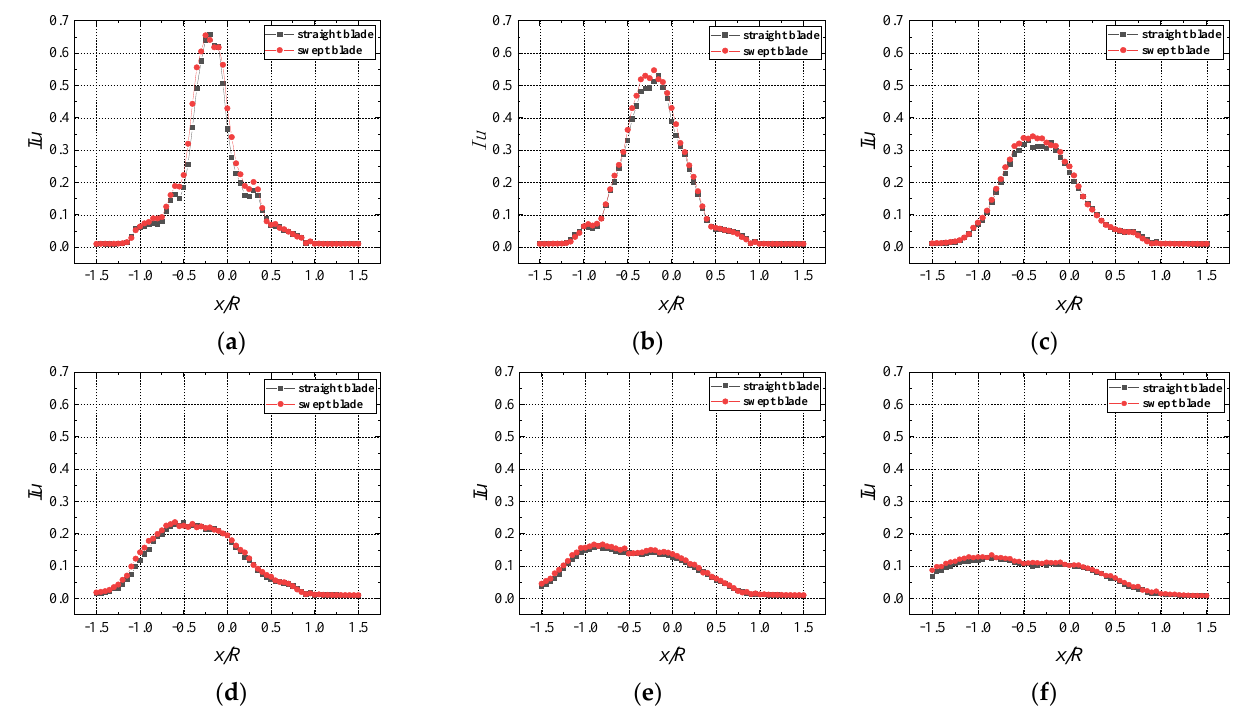
Figure 15. Streamwise turbulence intensity distribution at a yaw angle of 20° when λ = 4.1 . ( a ) 0.5D; ( b ) 1D; ( c ) 2D; ( d ) 3D; ( e ) 5D; ( f ) 8D.